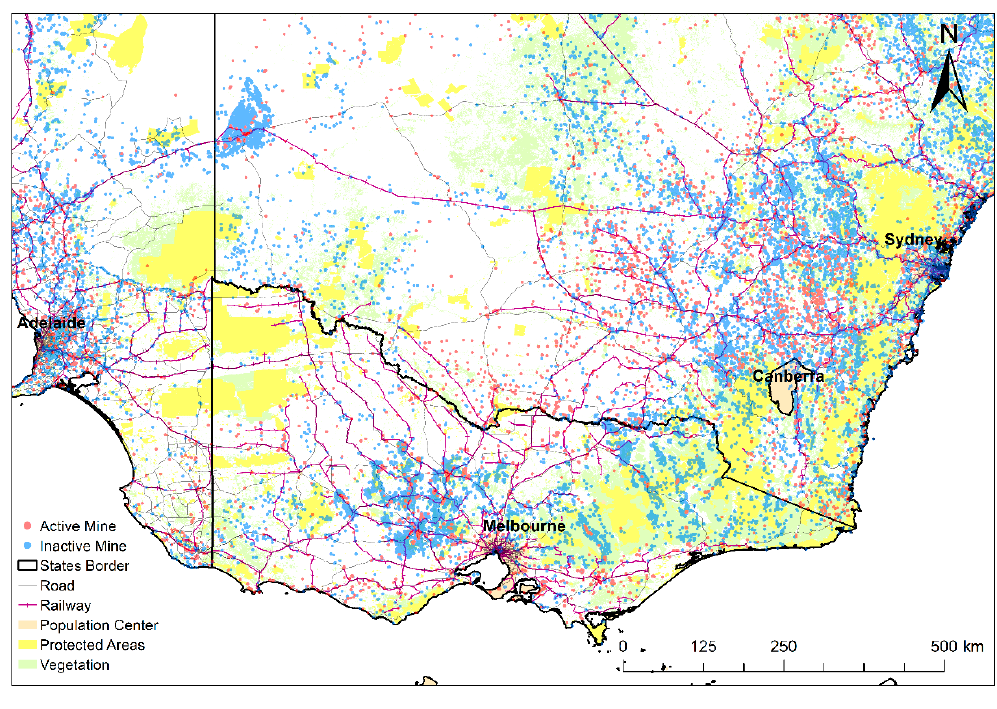
Figure 4. Cross-border spatial distribution of active and inactive mines alongside major transport corridors, urban centres, protected areas and vegetation in south-east Australia.